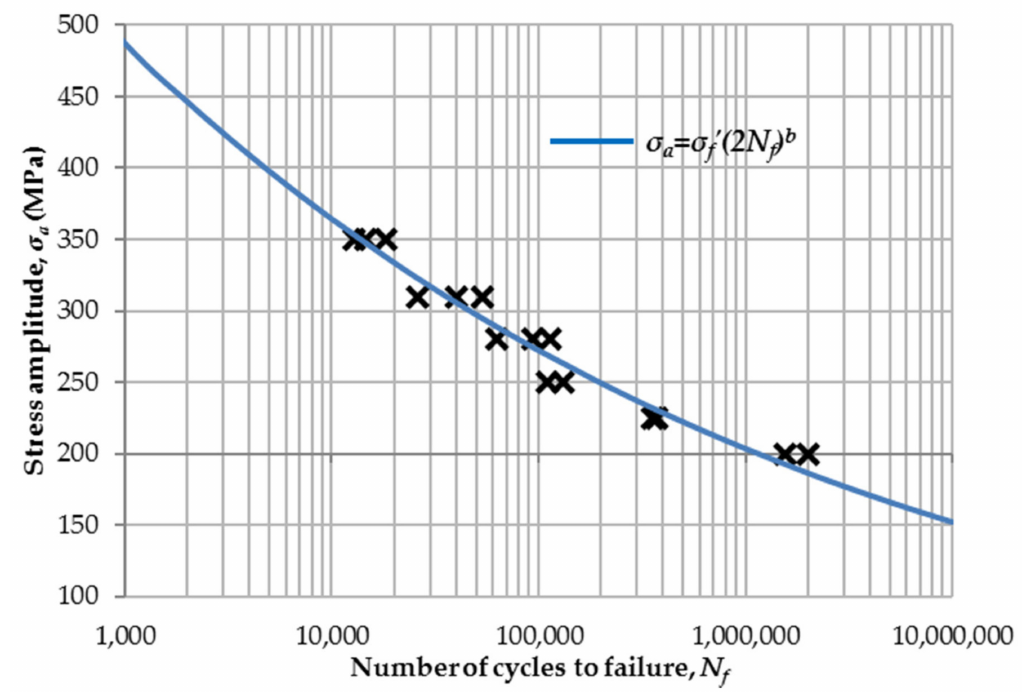
Figure 6. Semi-log S – N curve for uniaxial stress-controlled tests of S355J2+N steel